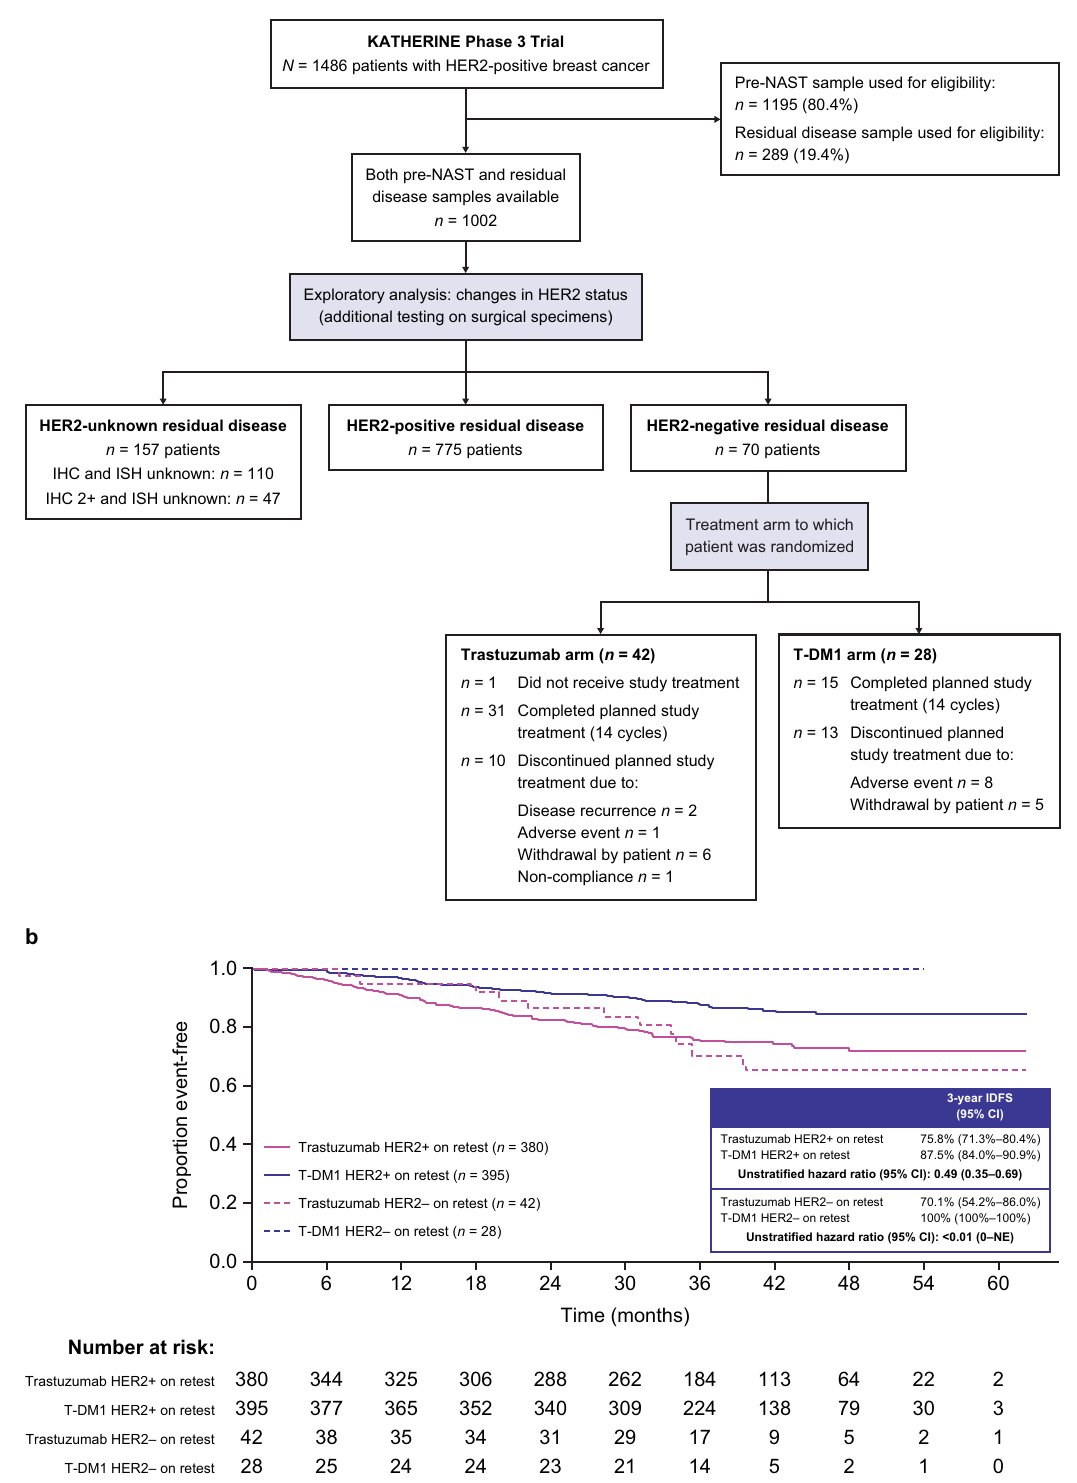
Fig. 1 Analysis of outcomes in patients with HER2-negative vs HER2-positive residual disease upon retesting at surgery. a Patient data assessed for this analysis is shown. Of the 1486 enrolled patients, two in the trastuzumab arm were excluded from the analysis, one without centrally con fi rmed HER2-positive breast cancer and another who was inadvertently randomized twice. Paired pre-NAST and residual disease samples were available for 845 patients. Patients with HER2-negative residual disease ( n = 70) include 53 with con fi rmed HER2-negative disease and 17 with unknown HER2-status (IHC 0 – 1 + /ISH unknown). b Kaplan – Meier estimates of time to fi rst IDFS event in each treatment arm are shown. Abbreviations: CI con fi dence interval, HER2 human epidermal growth factor receptor 2, IDFS invasive disease-free survival, NAST neoadjuvant systemic therapy, NE not estimable, and T-DM1 trastuzumab